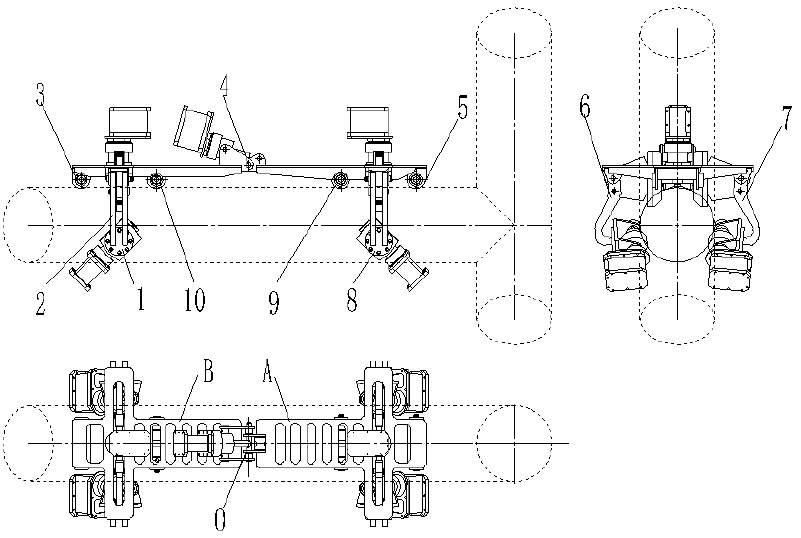
Fig. 1 Configuration of the out-pipe climbing robot. 1 - V-shaped drive assembly on part B; 2 - a leg of part B; 3,10 - guiding wheels of part B; 4 - hinged shaft of parts A and B; 5, 9 - the guiding wheel of part A; 6 - the left leg; 7 - the right leg; 8 - inverted V-shaped drive assembly of part A; O - the intersection of the hinged centre of parts A and B and the left and right symmetrical plane of the whole machine.